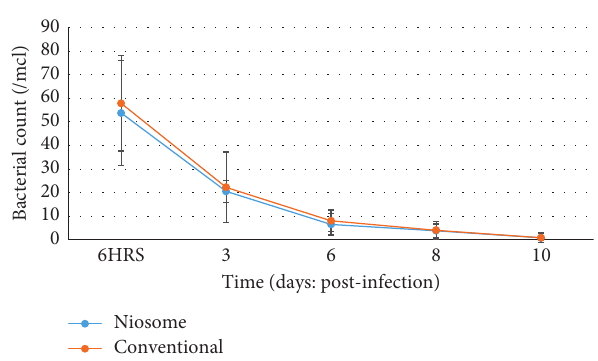
Figure 8: Graph showing bacterial counts in Sprague Dawley rats after infection with Pseudomonas aeruginosa and treatment with niosome and conventional levofloxacin ( p < 0 . 919).